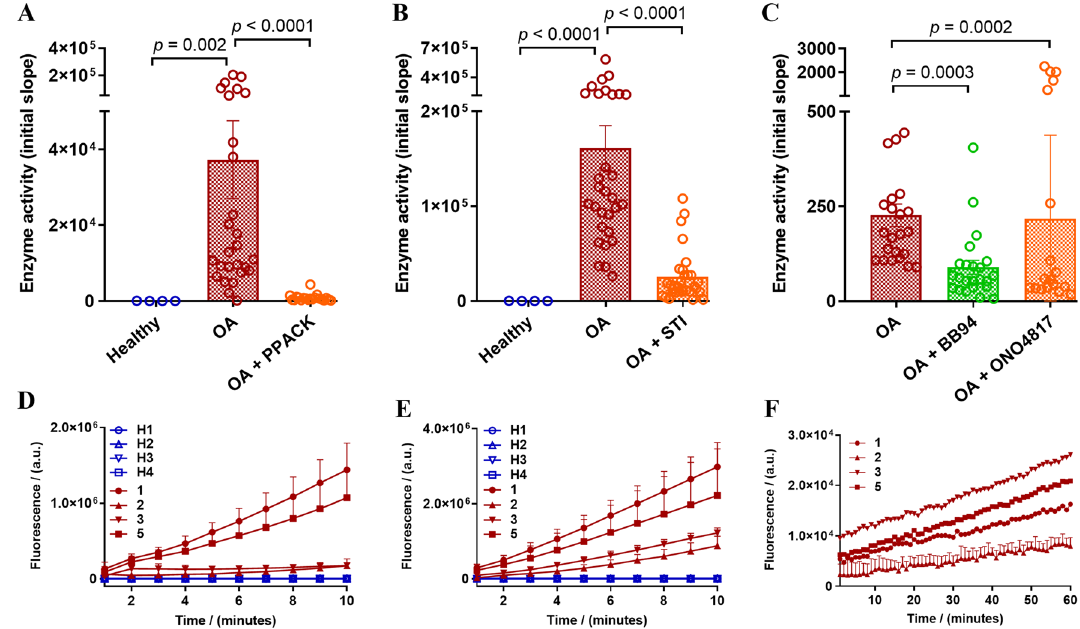
Figure 4. Cleavage of enzyme class preferred fluorogenic substrates by healthy and OA knee joint synovial fluids. Fluorogenic substrates were incubated with the healthy and OA synovial fluids (10%) with and without enzyme inhibitors (PPACK, STI, BB-94 or ONO-4817) and cleavage of ( A ) Bz-FVR-AMC (thrombin-like enzymes), ( B ) Boc-QAR-AMC (trypsin-like enzymes), and ( C ) MCA-KPLGL-Dpa(DNP)-AR-NH 2 (MMPs) substrates was monitored. Representative kinetic traces of four healthy and four patient samples obtained with ( D ) Bz-FVR-AMC (10 min) and ( E ) Boc-QAR-AMC (10 min), and ( F ) four patient samples with MCA-KPLGL- Dpa(DNP)-AR-NH 2 (60 min) substrates. The data represents the mean ± SEM ( N = 1–3). One-Way ANOVA Kruskal–Wallis test was utilized to assess differences between groups. p < 0.05 was considered statistically